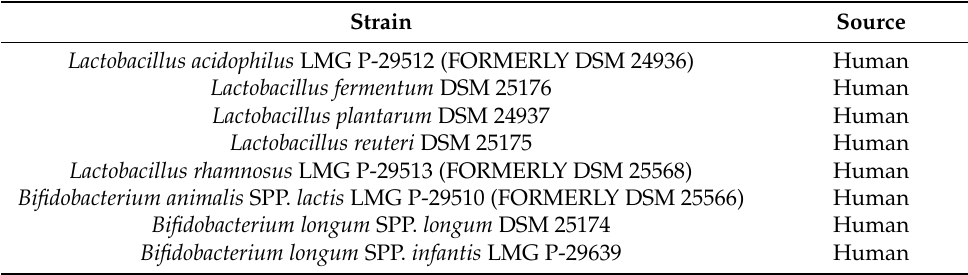
Table 1. Bacterial strains used in this